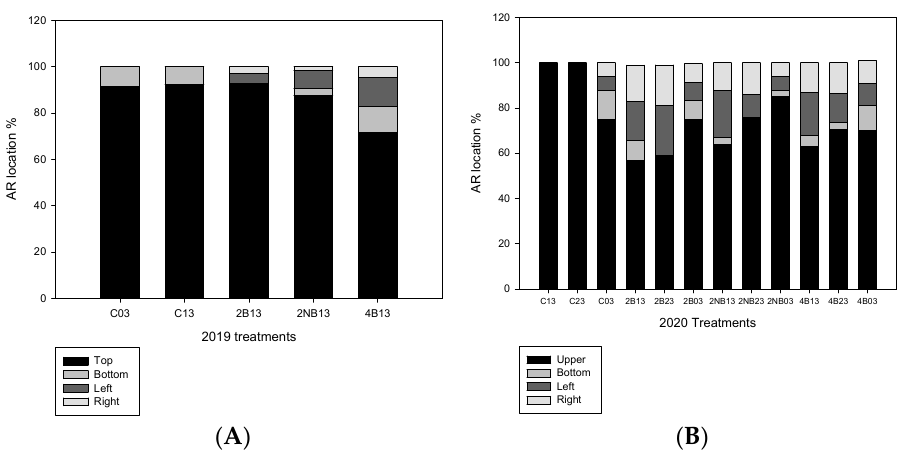
Figure 3. Location distribution of adventitious roots’ (ARs) emergence. Most of the ARs were regenerated at the upper edge of the wounds. ( A ) 2019: C03 treatment had 92% of rooting wounds regenerating ARs from the upper edge, and C13 treatment had 90%. The 4B13 and 2NB13 treatments showed diverse distributions of ARs on the four edges of the wounds compared to the water treatments. ( B ) 2020: the three treatments in each 2B and 4B solution had more diversified distribution percentages of ARs on the four edges of the wounds. The two water treatments, C13 and C23, had all ARs concentrated at the upper edge of the wounds.